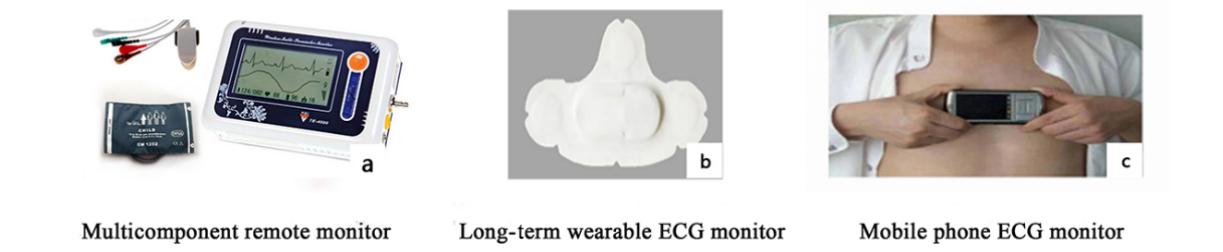
Figure 2. Smart health tracking devices. ECG: